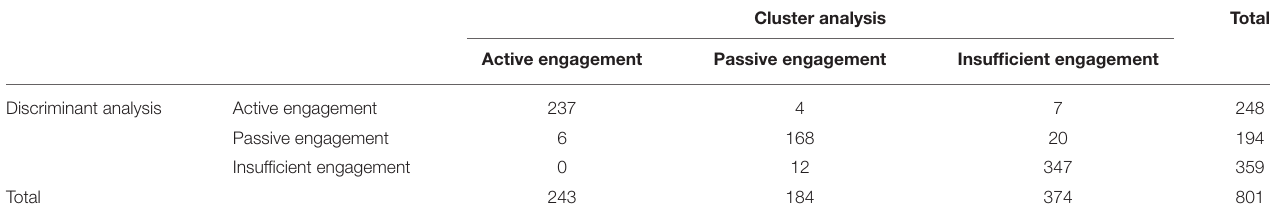
TABLE 5 | Comparison between cluster analysis and discriminant analysis